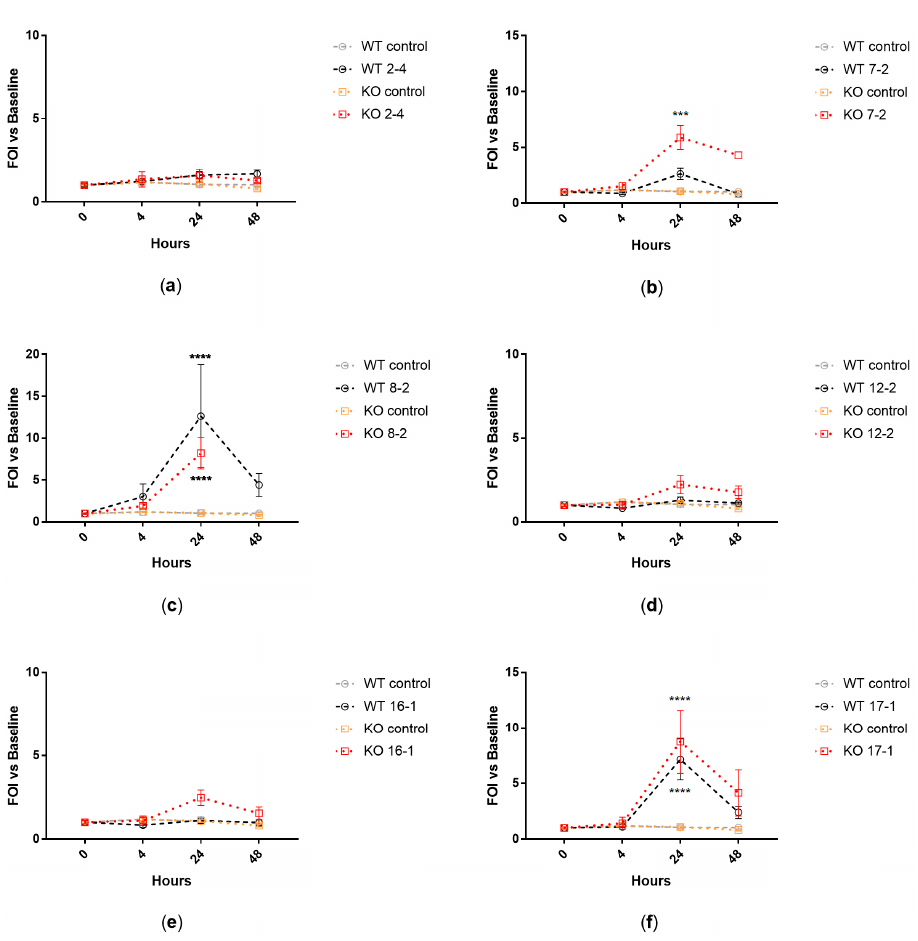
Figure 2. IL-8-dependent bioluminescence emi tt ed by WT and KO mice after intratracheal challenge with each clinical isolate: 2-4 ( a ), 7-2 ( b ), 8-2 ( c ), 12-2 ( d ), 16-1 ( e ), 17-1 ( f ), 20-1 ( g ), 23-1 ( h ). Imaging was performed before lung challenge (0 h) and after 4, 24, and 48 h. FOI = Folds of Induction vs. baseline (0 h). Each value represents the mean ± SEM of four animals. Statistical analysis of treated vs. control mice was performed by repeated measures 2-way ANOVA followed by Tukey’s multiple comparison test; *** p < 0.001, **** p < 0.0001. 2.2. Mice Survival during Acute Infection with Isolates Exhibiting Di ff erent Pathogenic Characteristics Mice survival was monitored up to 96 h from the intratracheal challenge with the clinical isolates. Isolates showing high–medium virulence in larvae induced significantly higher mortality in both WT ( p = 0.0035) and KO ( p = 0.0012) mice in comparison to isolates with low– no virulence (Figure 3). When analyzing the isolates individually, two strains showing high– medium virulence activity caused over 65% mortality within 72 h from lung challenge in both